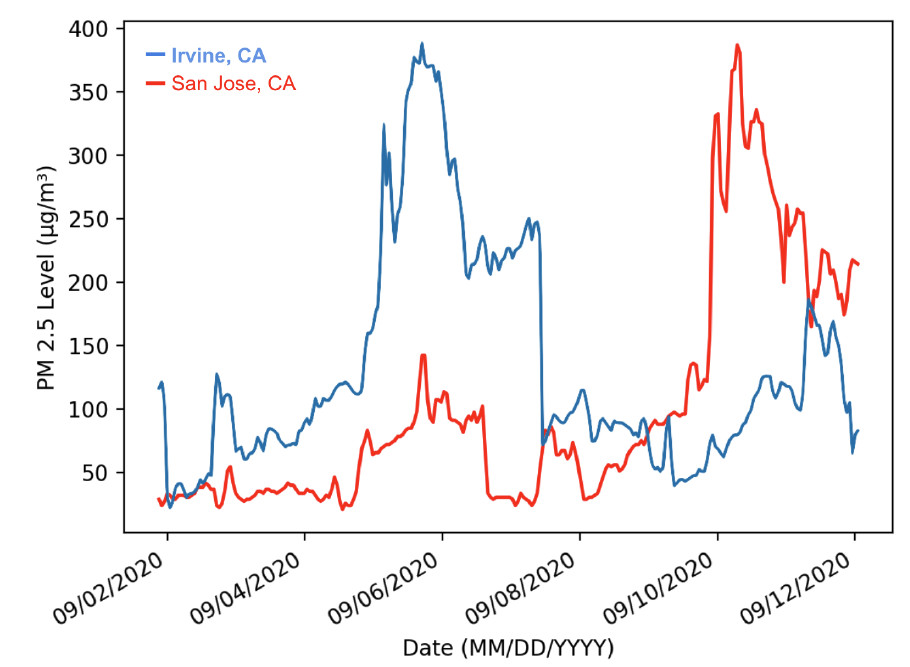
Figure 4. Sensors deployed by PurpleAir in Irvine and San Jose showed that the PM 2.5 concentration spiked to dangerous levels during 2–13 September 2020, fire season. The onsets of spikes on 6 September and 10 September correspond to the El Dorado Fire and the SCU Lightning Fire